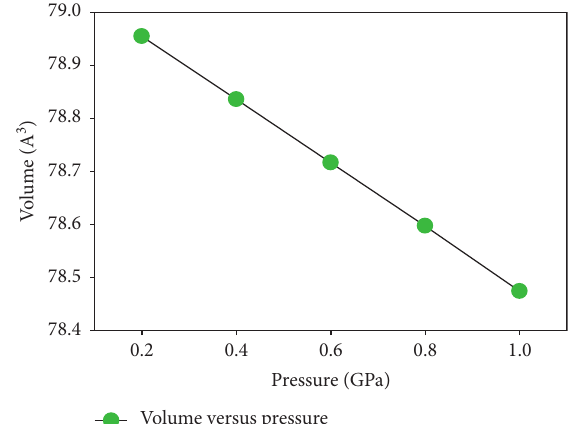
Figure 3: Up to a pressure of 1GPa, application of pressure on the system leads to a decrease in the volume as expected from past experimental studies on the pnictide [1, 11,